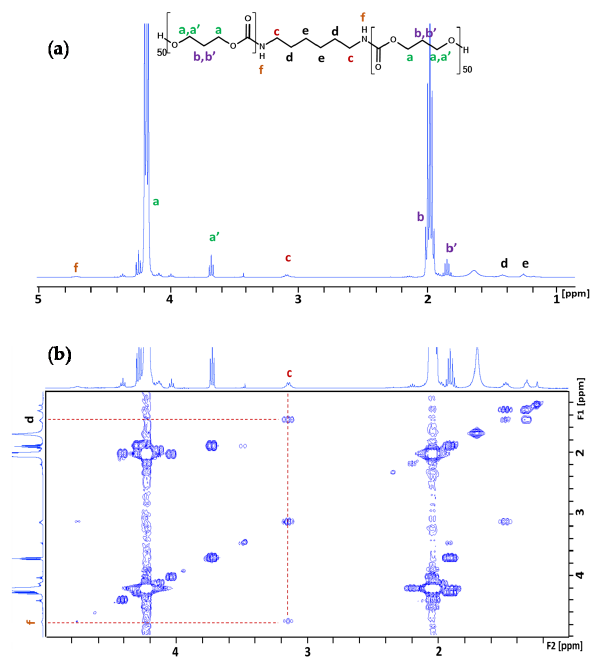
Figure 3. ( a ) 1 H NMR and ( b ) 2D-COSY NMR of PTMC initiated by 1,6-hexanediamine with Sn(Oct) 2 (CDCl 3